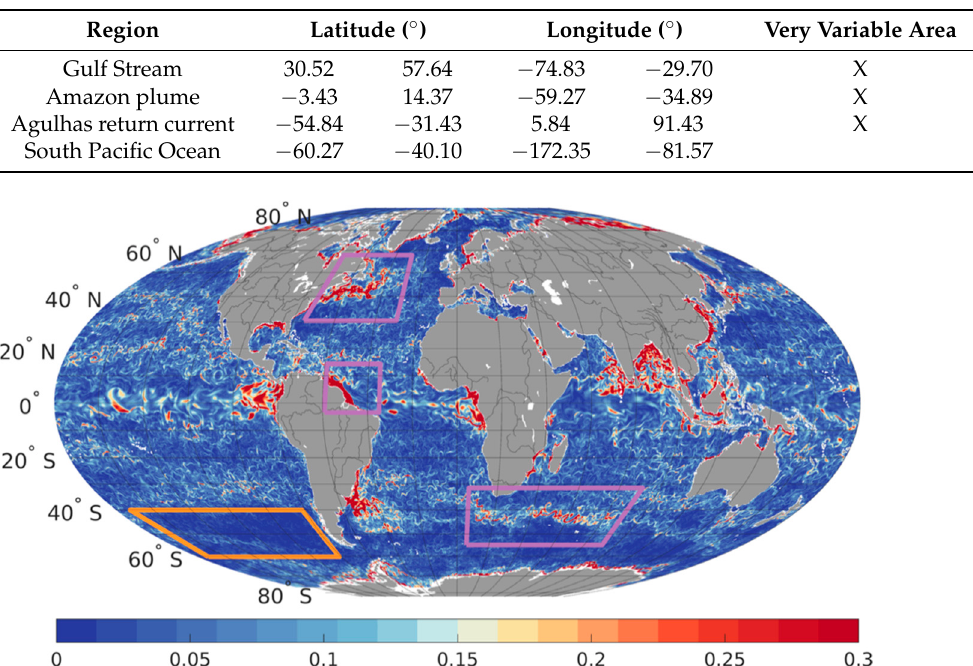
Table 1. Definition of regions shown on Figure 2.